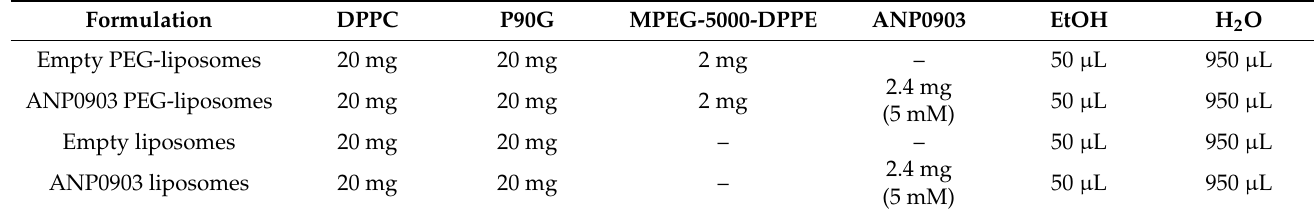
Table 4. Composition of the liposomal